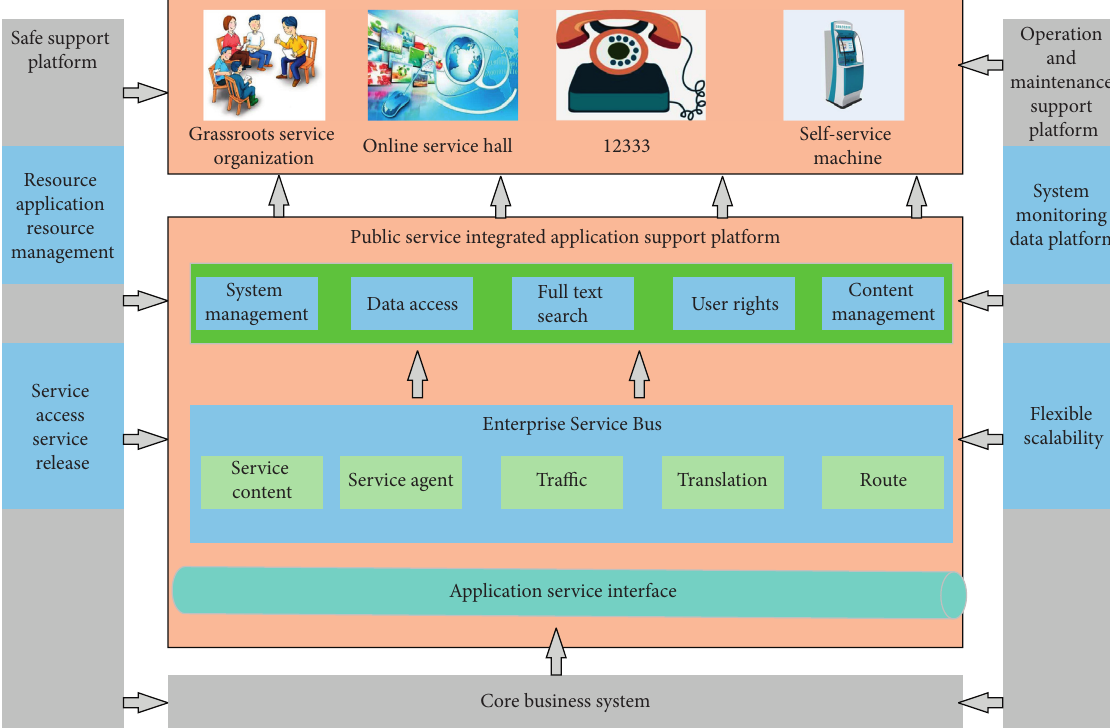
Figure 3: Design of a smart tourism public service system